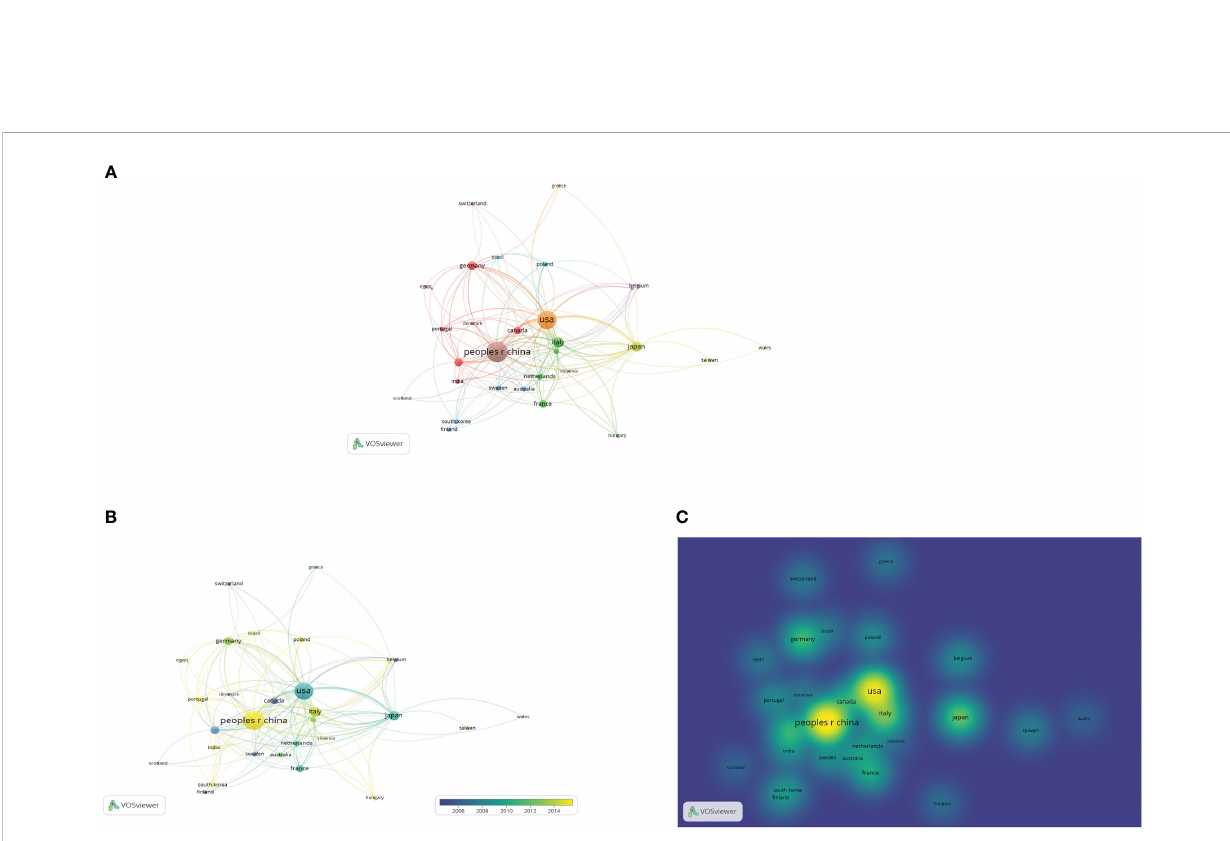
FIGURE 6 National and regional collaborations in the fi eld of osteosarcoma metabolism. (A-C) are the network of connections between countries or regions, the graph of author ’ s hotness over time, and the graph of author ’ s density, respectively.